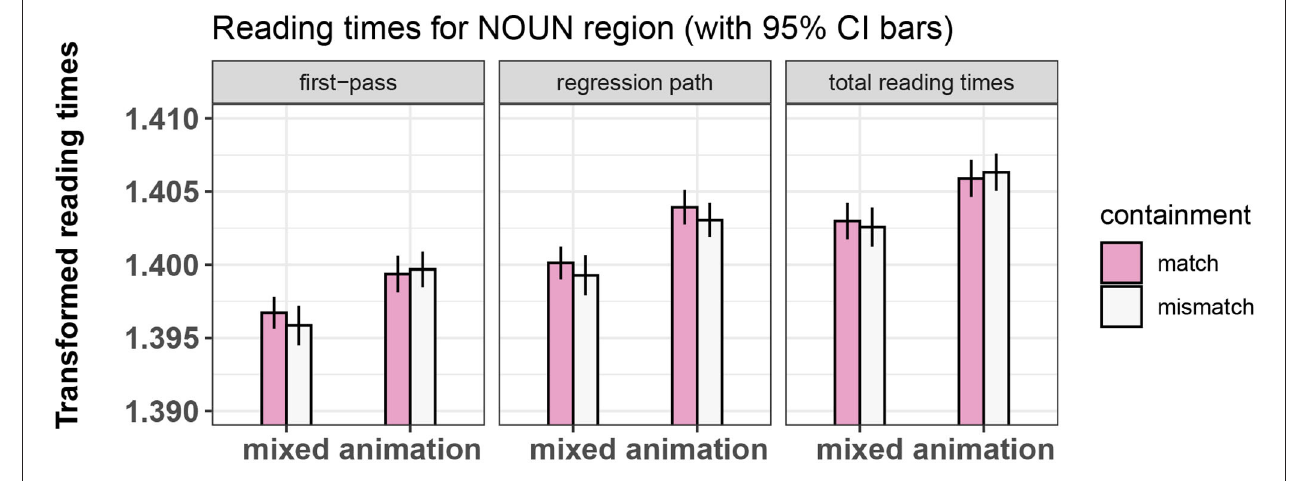
FIGURE 4 | Summary of results for the NOUN region, Experiment 1.